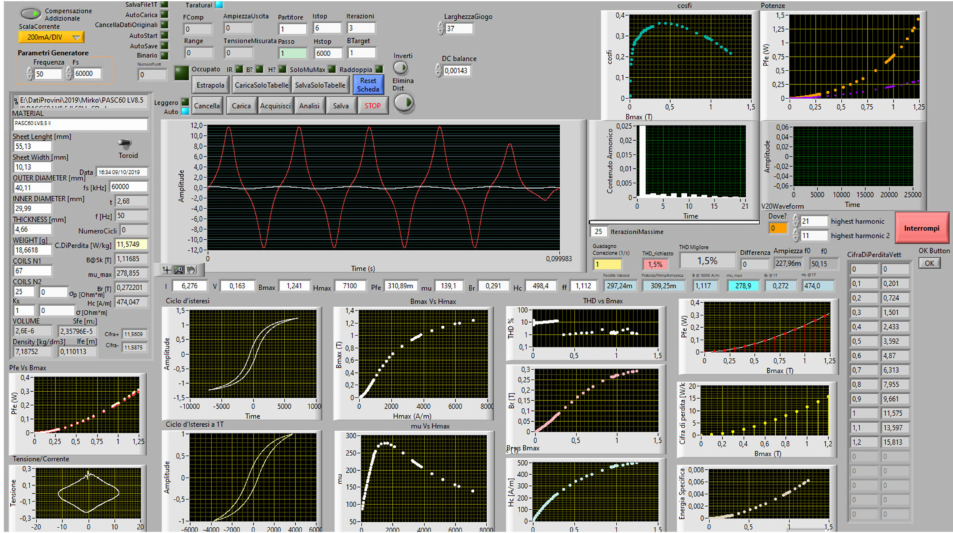
Figure 6. LabView interface with real-time flux waveform control and advanced elaboration of magnetic and losses